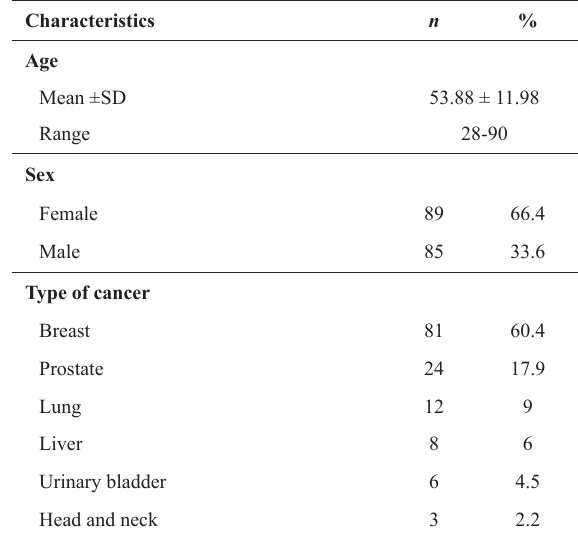
Table 1: Characteristics of 134 patients.